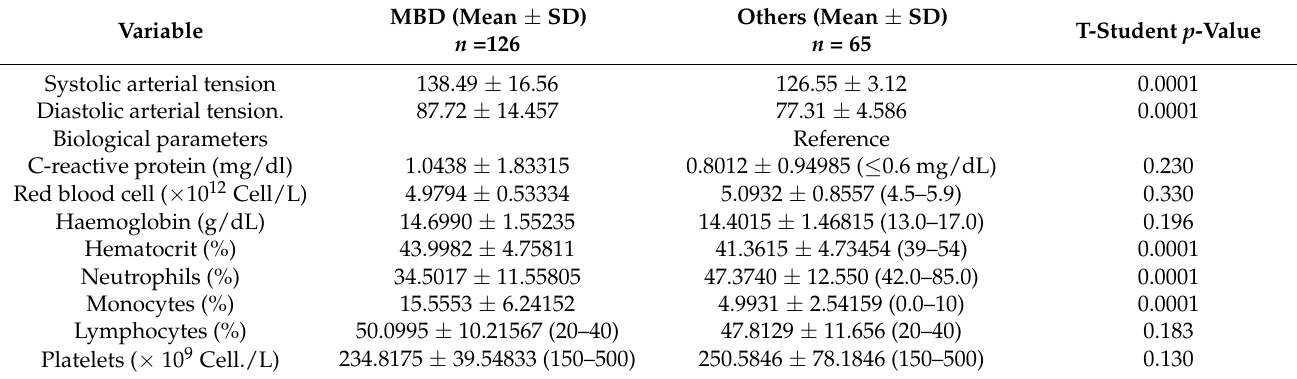
Table 5. Anthropometric parameters and haematological parameters and C-reactive protein in motorbikes. Variable Systolic arterial tension Diastolic arterial